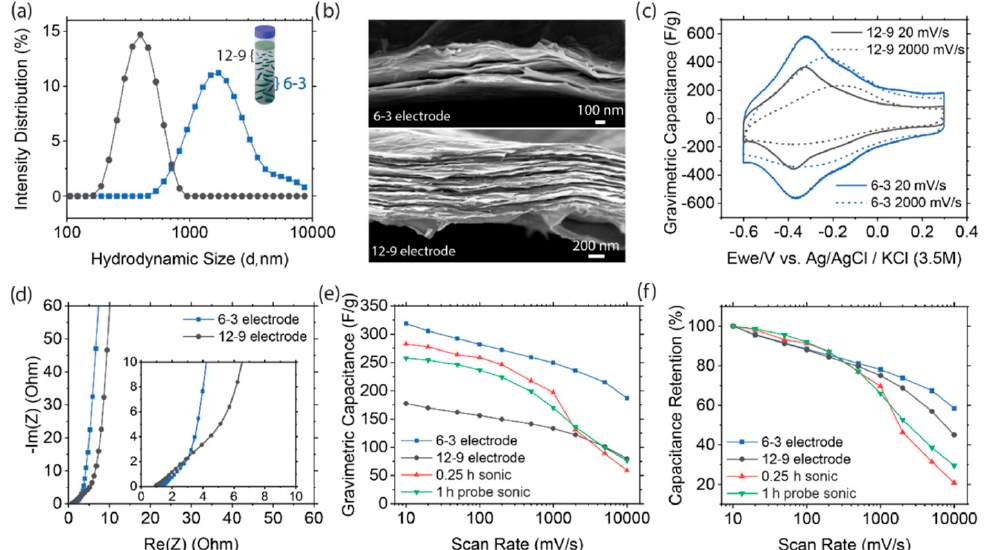
Figure 3. ( a ) Dynamic light scattering of the 6 − 3 mL fraction (blue) and the 12 − 9 mL fraction (black); ( b ) Cross-sectional SEM of the 6 − 3 electrode and the 12 − 9 electrode; ( c ) Cyclic voltammetry curves in 3M H 2 SO 4 electrolyte at different scan rates; ( d ) EIS curves for electrodes obtained by density gradient centrifugation with a high-frequency range in the inset; ( e ) Gravimetric capacitance vs scan rate; ( f ) capacitance retention of the BS − 0.25 h sonic (red triangles), PS − 1.0 h sonic (green triangles), 6 − 3 electrode (blue squares), and the 12 − 9 electrode (black circles). Reprinted with permission from [45]. Copyright 2018, American Chemical